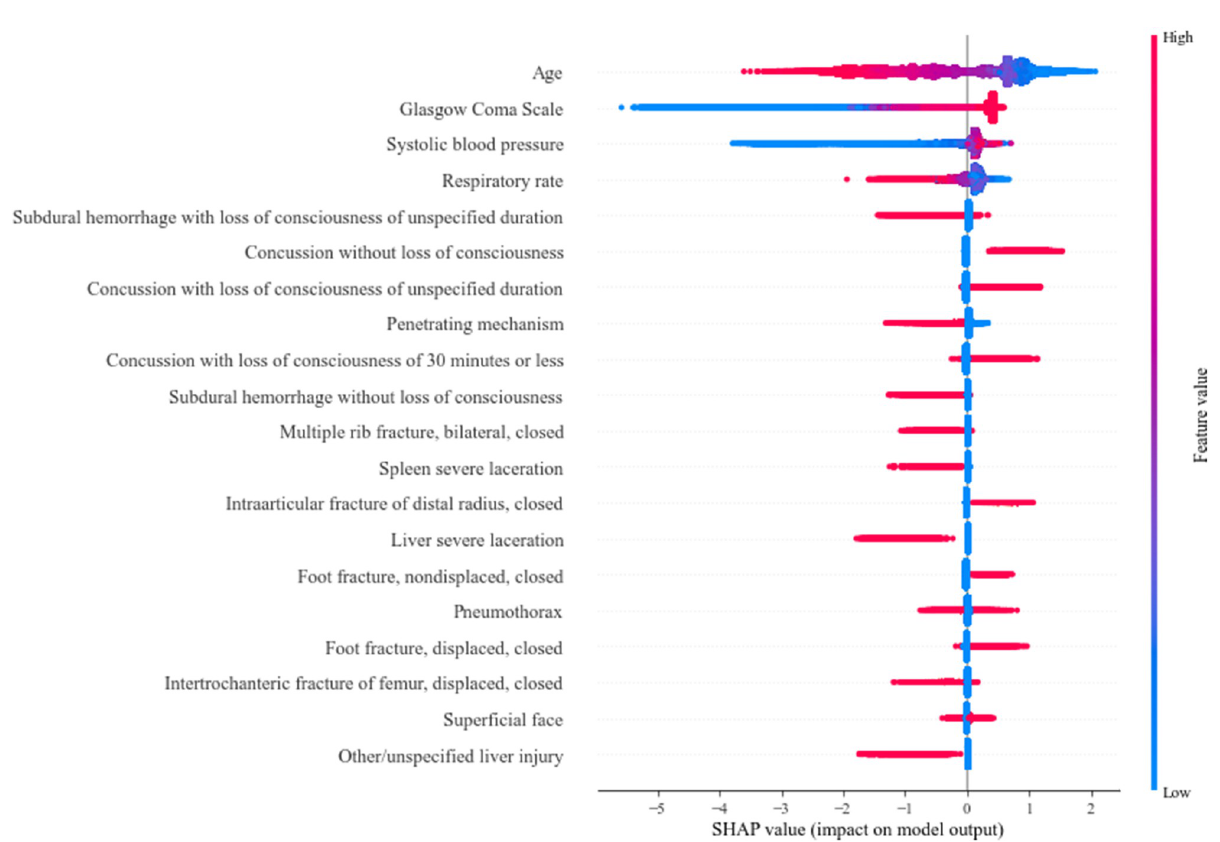
Fig 5. SHAP plot demonstrating the 20 most important features in the XGBoost model. Features ranked by descending importance. Red points designate higher values for that feature while blue points denote lower values.